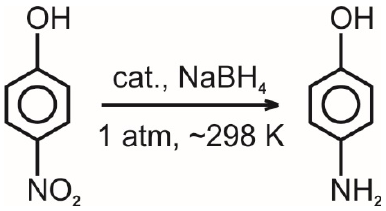
Figure 6. Schematic representation of the studied catalytic reaction.